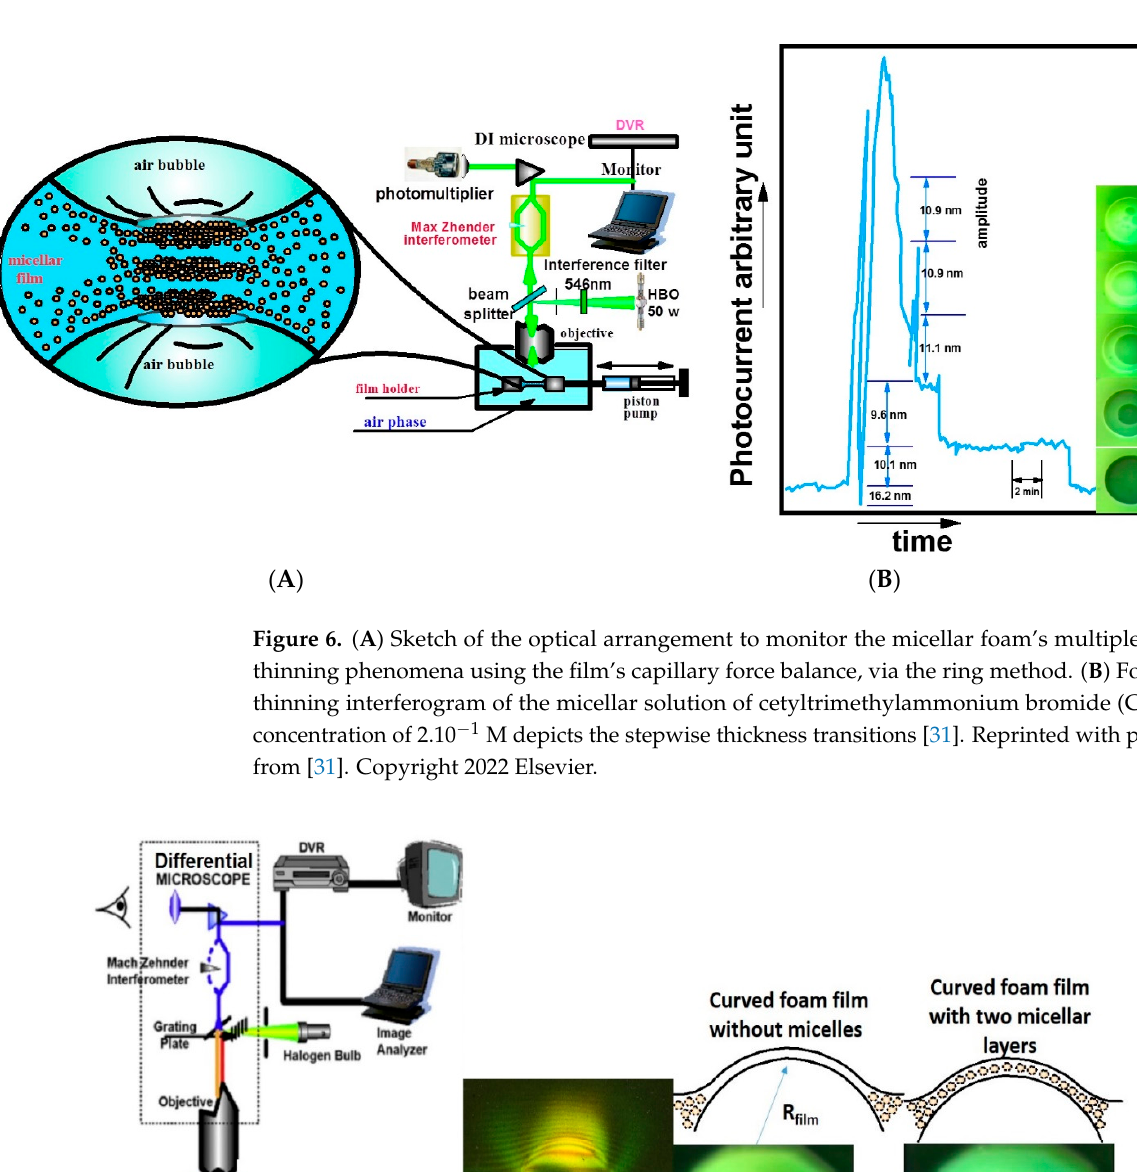
Figure 7. ( A ) Sketch of the setup for monitoring the curved micellar film thinning of an air bubble attached to the air–micellar solution. ( B ) Micro-interferometry photo of the foam curved film under differential interferometry (DI) [43,44]. ( C ) Attached air bubble at the surface of a cetyltrimethylam- monium bromide (CTAB) solution at a concentration of 2.10 − 1 M. ( D ) Attached air bubble using the same micellar concentration, but with a smaller foam lamella area [14]. Reprinted with permission from [31]. Copyright 2022